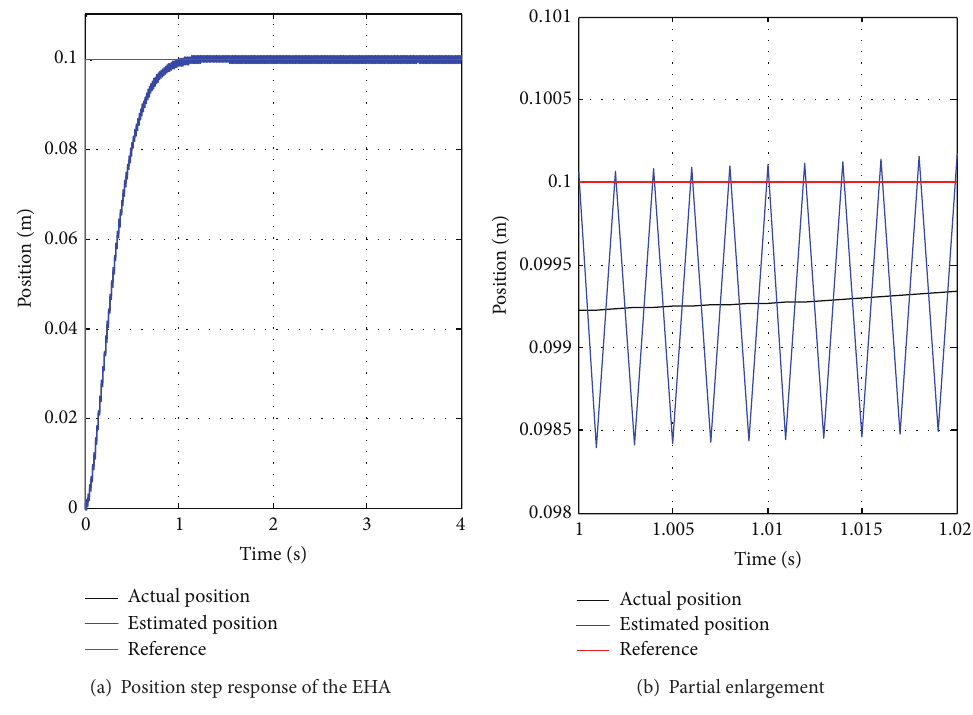
Figure 3: Actual and estimated position of the EHA.